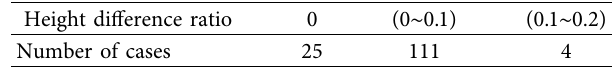
Figure 3: Comparison of conductor tension between this paper and the literature. Table 3: The range of height difference ratio in transmission